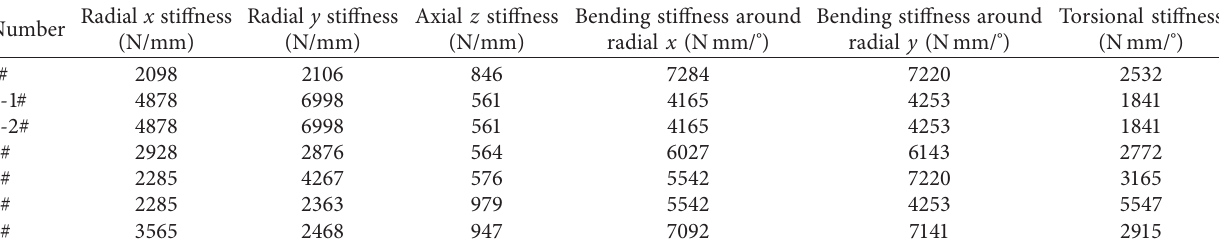
Figure 8: Vertical dynamics performance of different drive system arrangement schemes: (a) comparison of smoothness indicators between the integrated drive system and hub motor drive system and (b) grounding index comparison between the integrated drive system and hub motor drive system. Table 7: Six-degree-of-freedom of bushing